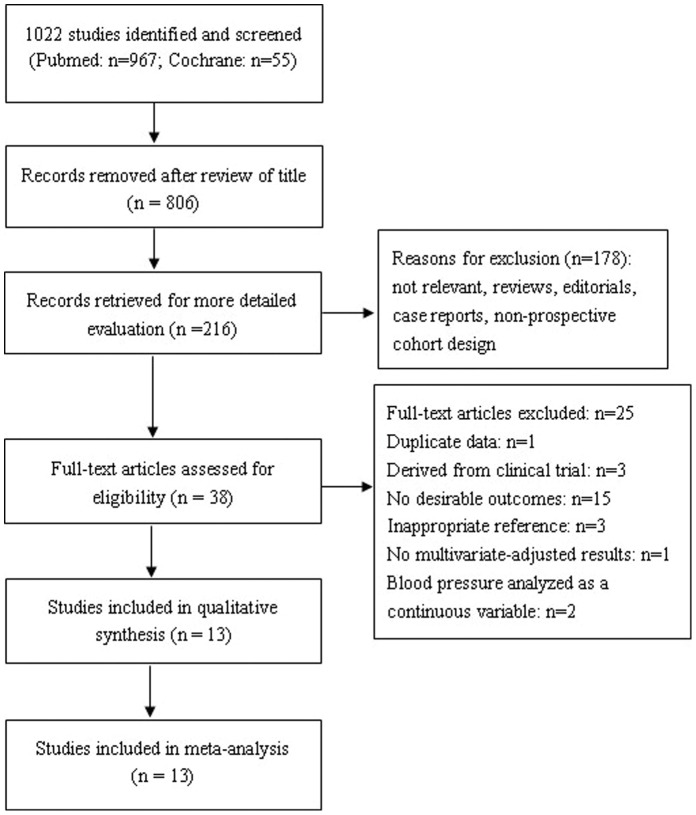
Flow chart of the study selection process.